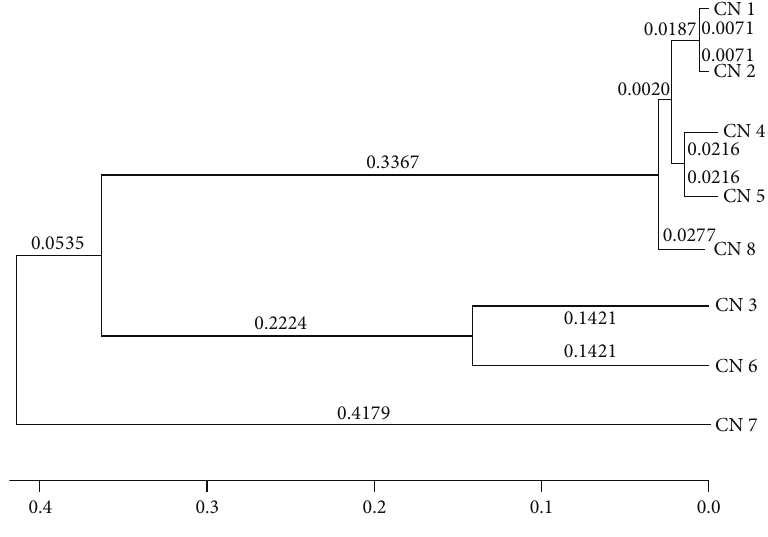
Figure 3: Phylogenetic tree showing relationship of mushroom